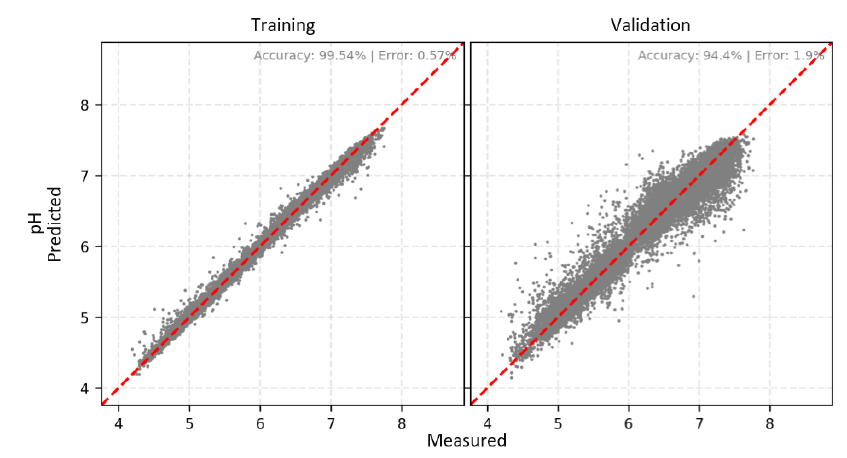
Figure 6. Predicted vs. measured (variance introduced pixel values) pH values for the training and validation data. The red broken line represents the 1:1 line.